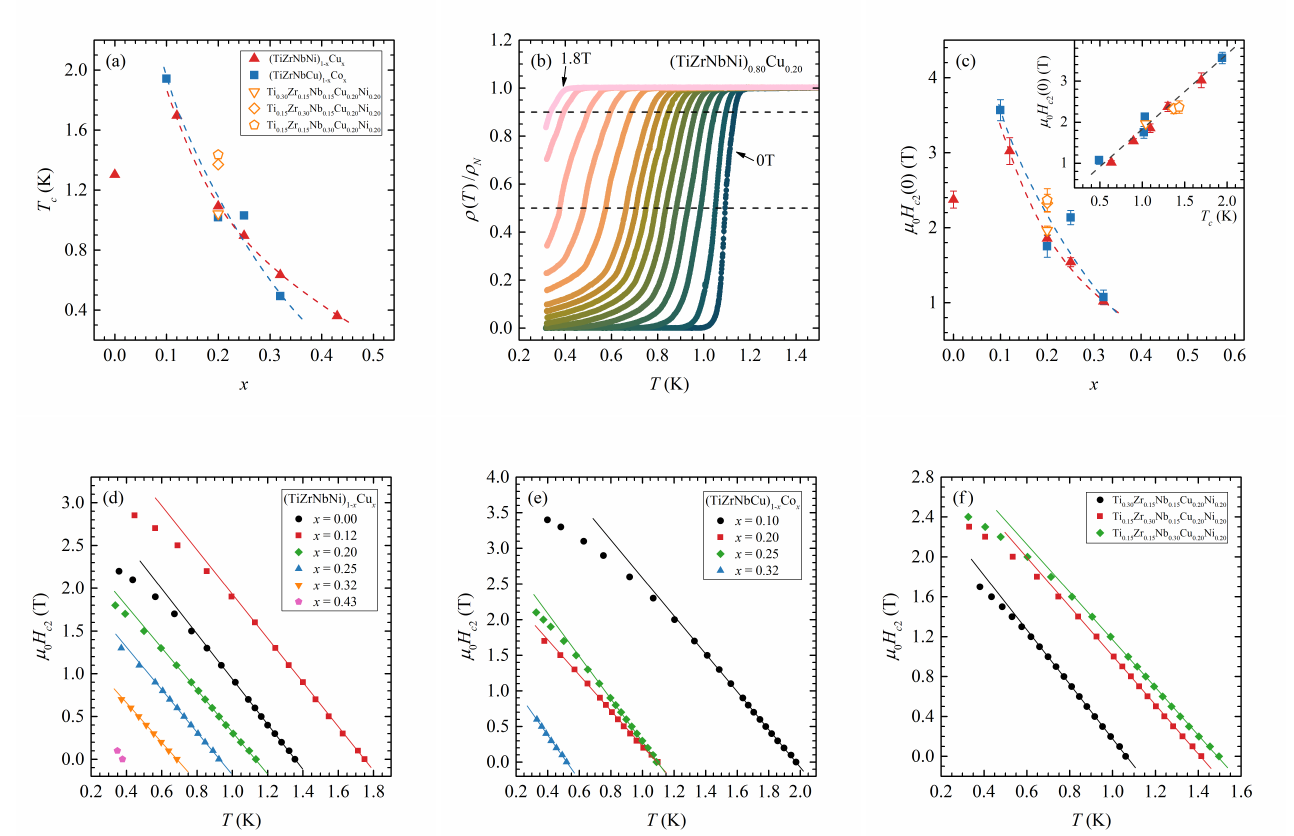
Figure 2. ( a ) The composition x dependence of the superconducting transition temperatures T c for ( TiZrNbNi ) ( TiZrNbCu ) 1 − x Cu x (red triangles), 1 − x Co x (blue squares) and three additional alloys with fixed (CuNi) content (open triangles, diamonds and pentagons). The dashed lines are guides to the eye. ( b ) The temperature dependence of the normalized resistivity ρ ( T ) / ρ N close to the superconducting transition for the Cu 0.20 sample in constant magnetic fields from 0–1.8 T . ( c ) The composition x dependence of the upper critical fields at zero temperature µ 0 H c 2 ( 0 ) (see panel ( a ) for details). Inset: µ 0 H c 2 ( 0 ) vs. T c for all samples; the dashed line corresponds to the Pauli paramagnetic = 1.83 T c . ( d – f ) The temperature dependence of the upper critical fields µ ( T ) for limit µ 0 H Pauli 0 H c 2 c 2 ( TiZrNbNi ) ( TiZrNbCu ) 1 − x Cu x , 1 − x Co x and three additional alloys with fixed (CuNi) content. The lines represent the initial slopes of the upper critical field ( µ 0 dH c 2 / dT ) T = T c